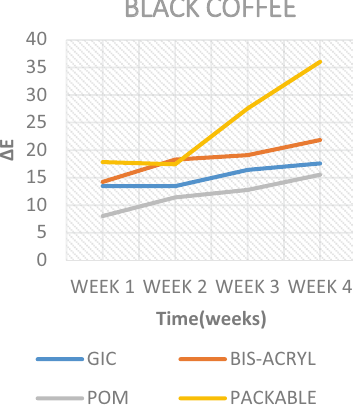
Fig. 11 Colour change over time of test materials in energy drink.